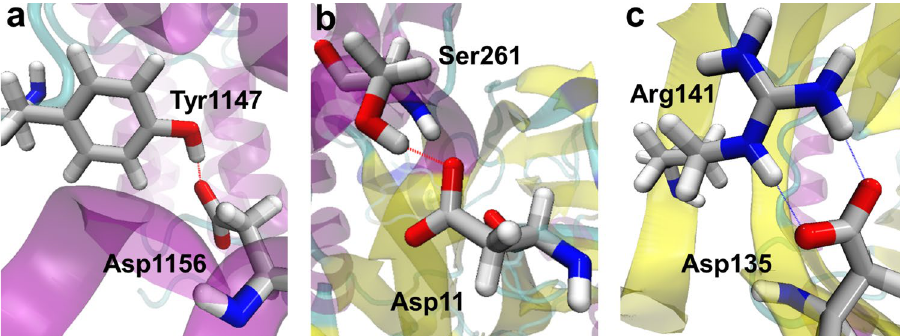
Figure 3. Structures of the Tyr-Asp, Ser-Asp and Arg-Asp side chain-side chain hydrogen bonds that represent their most probable geometry arrangements in proteins. ( a ) A SHB between Tyr1147 and Asp1156 (R = 2.65 Å) in a CBP bromodomain (PDB ID 5I86) 50 . ( b ) A SHB between Ser261 and Asp11 (R = 2.65 Å) in an amidase mutant (PDB ID 4LF0) 51 . ( c ) Two regular hydrogen bonds between Arg141 and Asp135 (R = 2.79 Å and 2.85 Å) in the majastridin protein (PDB ID 2NXV) 52